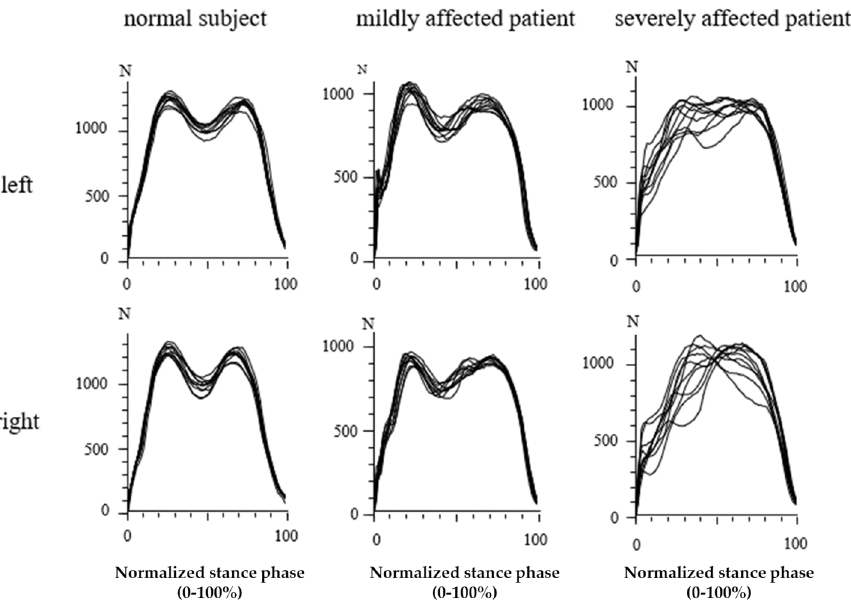
Figure 4. Superposition of the GRF-curves of the same subject and patients as in Figure 3 after time normalization of the stance phase. The GRF-curves of the normal subject are highly reproducible ( left side ) with two peaks. In the moderately affected patient ( middle part ), the variability of the GRF-curves is much higher. In the severely affected patient ( right side ), no peaks can be distinguished anymore.